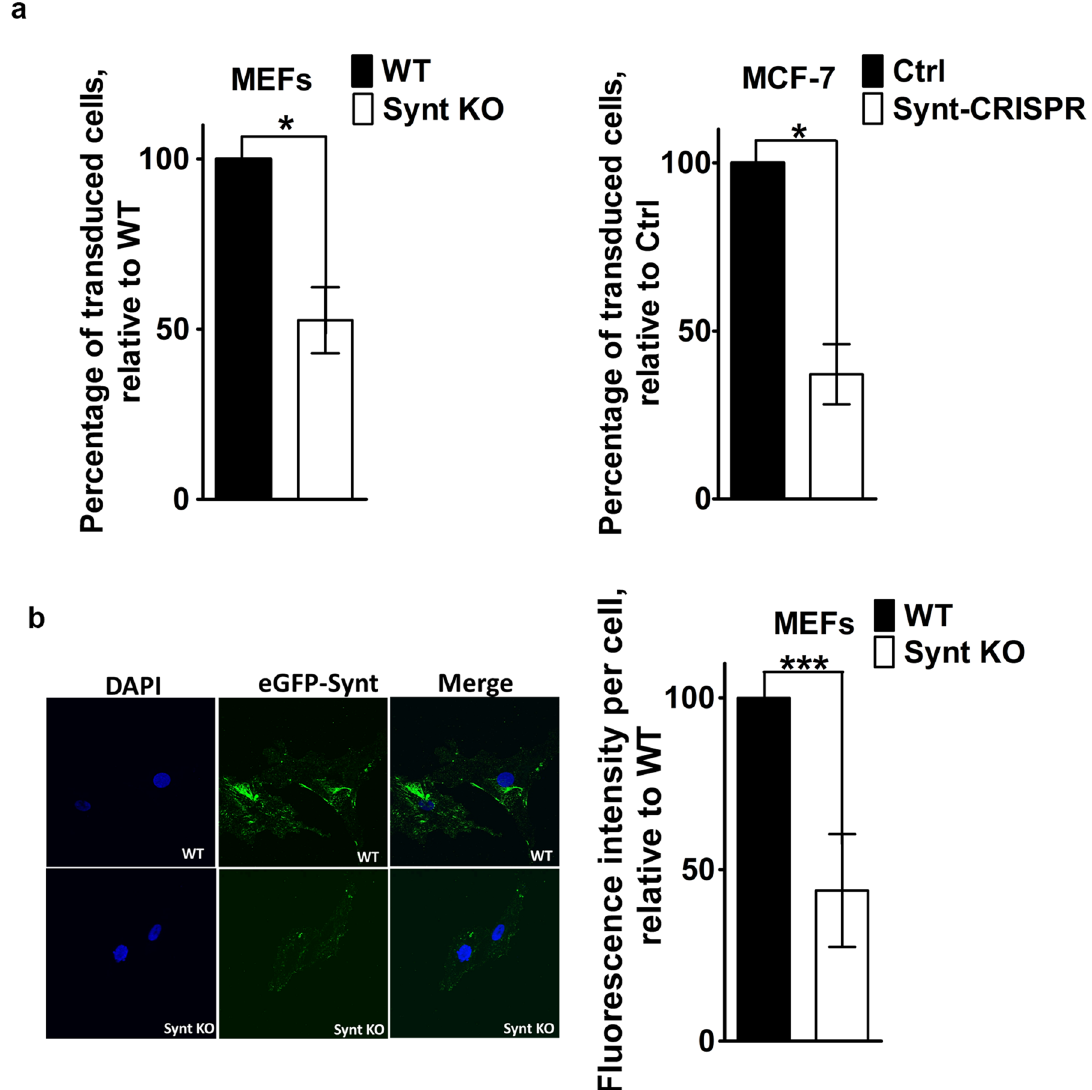
Figure 4. Loss of syntenin expression in primary MEFs limits retroviral transduction and exosome uptake. ( a ) Retroviral transduction. Retrovirus encoding LUC IRES eGFP, produced using phoenix packaging cells, was incubated with MEFs (WT and with Synt KO, shown on the left) and with MCF-7 cells (Ctrl and Synt-CRISPR, shown on the right), for 48 h. Cells expressing eGFP were quantified by flow cytometry. Bar graphs represent the percentage of cells transduced by retrovirus (i.e. expressing eGFP), relative to the percentage of WT cells that was transduced (taken as 100%). ( b ) Exosome uptake. MEFs, either WT or Synt-KO, were incubated with exosomes derived from MCF-7 cells expressing eGFP-syntenin (eGFP-Synt), at 37 °C for 8 h, to allow for exosome uptake, and then subjected to confocal laser scanning microscopy. Left: Representative confocal micrographs of MEFs, showing the accumulation of eGFP-Synt (green) and DAPI (blue) staining of the nuclei. Exosomes loaded with eGFP-Synt yield more puncta in WT cells than in Synt-KO cells. Right: quantification of mean eGFP fluorescence per